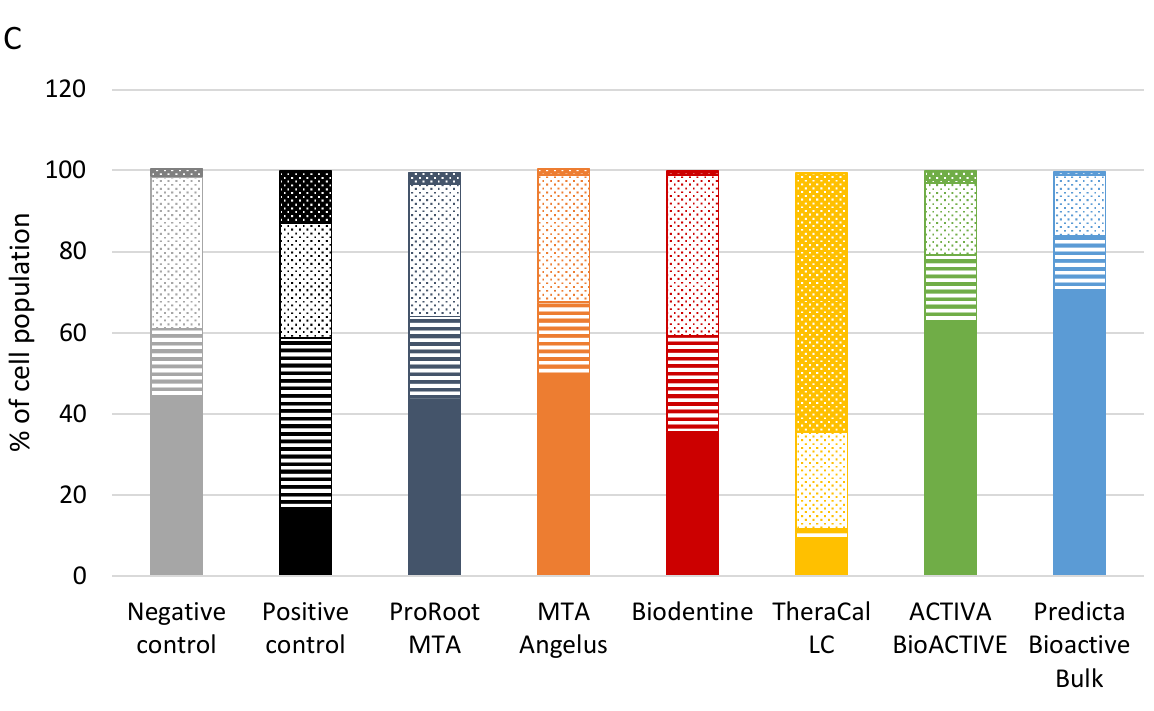
Figure 4. Flow cytometry (FC) analysis of cell cycle progression using propidium iodide (PI) staining after 24 and 48 h incubation ( A ) of cells with the tested compounds. Percentage of cells in each group after 24 h are presented below ( B ) and 48 h incubation ( C ). Cells treated with 1 μM nocodazole constituted a positive control. Cells cultured in the complete medium represented the negative control. Statistical significance on the graphs: *** p < 0.001 versus negative control.